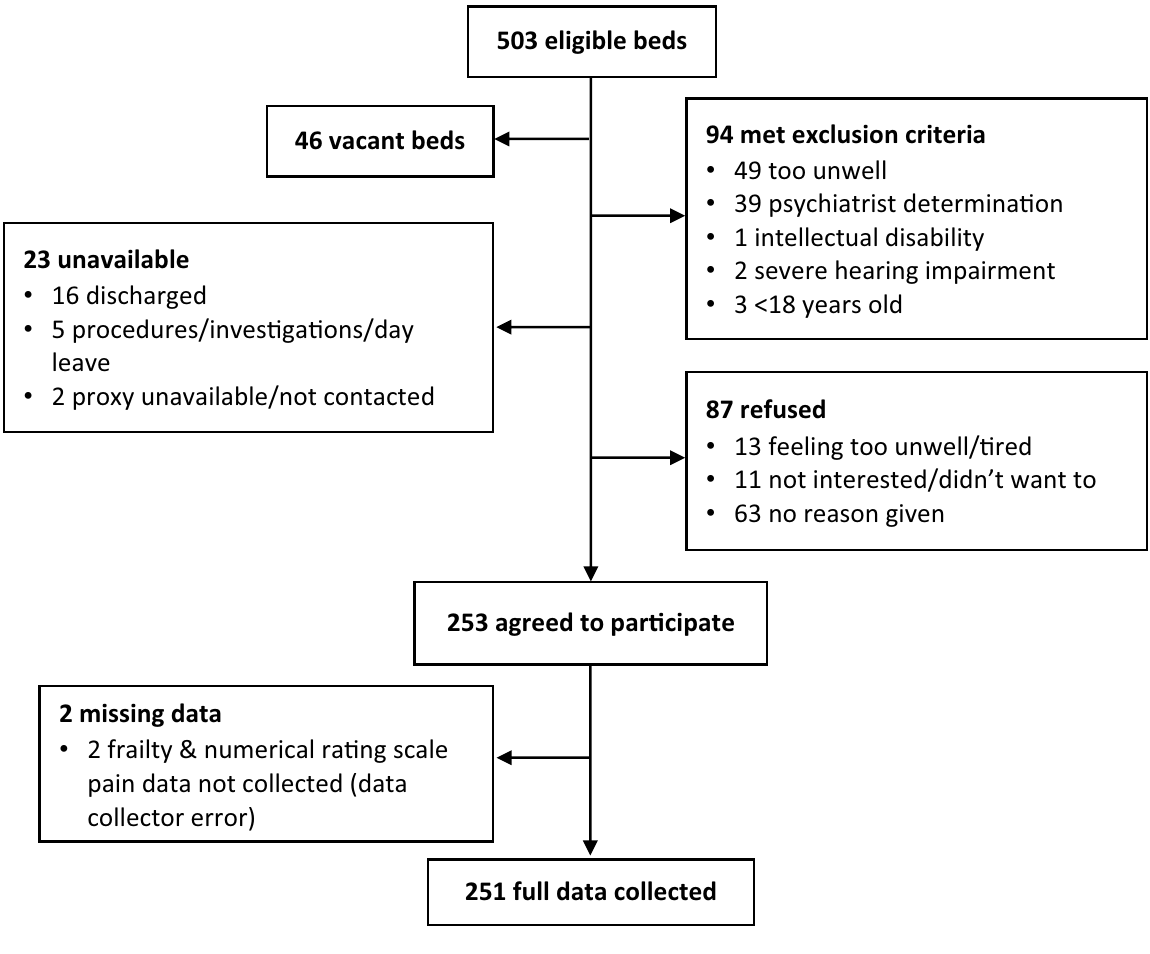
Figure 1. Participant recruitment